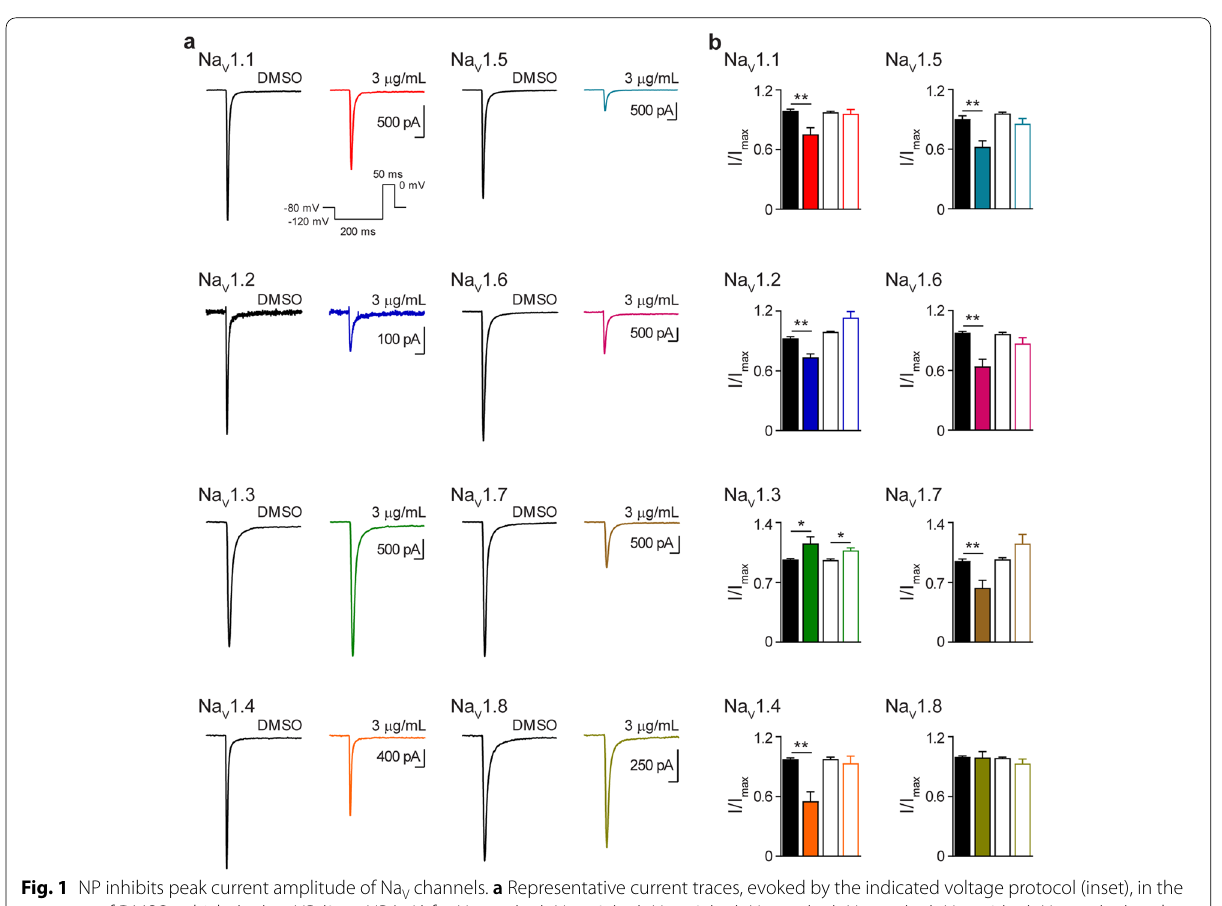
Fig. 1 NP inhibits peak current amplitude of Na V channels. a Representative current traces, evoked by the indicated voltage protocol (inset), in the presence of DMSO vehicle ( ) or NP (3 μg NP/mL) for Na V 1.1 ( ), Na V 1.2 ( ), Na V 1.3 ( ), Na V 1.4 ( ), Na V 1.5 ( ), Na V 1.6 ( ), Na V 1.7 ( ) and Na V 1.8 ( ) expressed in HEK 293 or CHO cells. Horizontal scale bars (2 ms) apply to all traces. b Mean normalized peak current amplitude (I/I max ) in the presence of DMSO vehicle ( ) or NP (3 μg NP/mL) for Na V 1.1 ( ; n 10), Na V 1.2 ( ; n 8), Na V 1.3 ( ; n 10), Na V 1.4 ( ; n 6), Na V 1.5 ( ; n 10), = = = = = Na V 1.6 ( ; n 11), Na V 1.7 ( ; n 7), Na V 1.8 ( ; n 7) and DMSO vehicle ( or, hemp seed oil (3 μg hemp seed oil/mL) for Na V 1.1 ( ; n 9), Na V 1.2 ( = = = = ; n 5), Na V 1.3 ( ; n 5), Na V 1.4 ( ; n 9), Na V 1.5 ( ; n 5), Na V 1.6 ( ; n 5), Na V 1.7 ( ; n 11) and Na V 1.8 ( ; n 7). Data points are mean SEM. Peak = = = = = = = ± current amplitudes in the presence of NP were compared to DMSO vehicle ( ) currents. Peak current amplitudes in the presence of hemp seed oil were compared to DMSO vehicle ( ) currents. Statistical significance is marked as * p< 0.05; ** p<